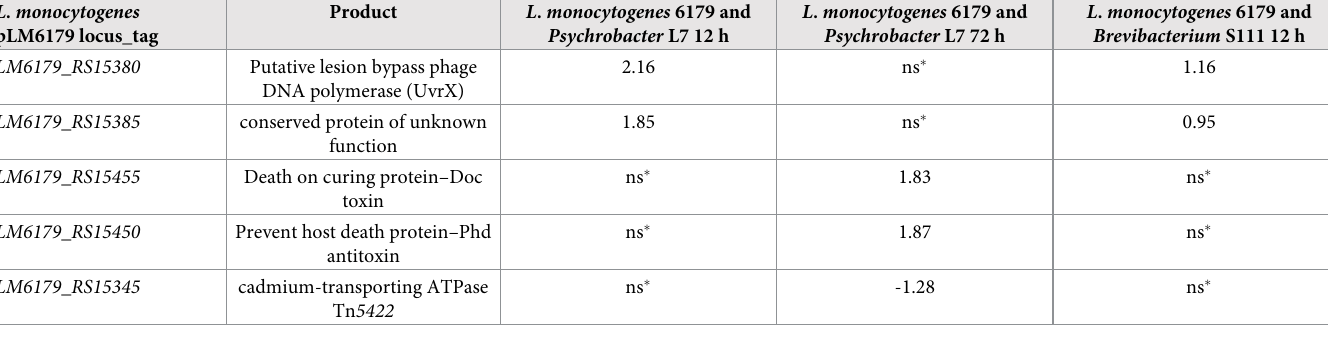
Table 5. Differentially expressed L . monocytogenes pLM6179 plasmid genes during co-cultivation with cheese rind bacteria. L . monocytogenes pLM6179